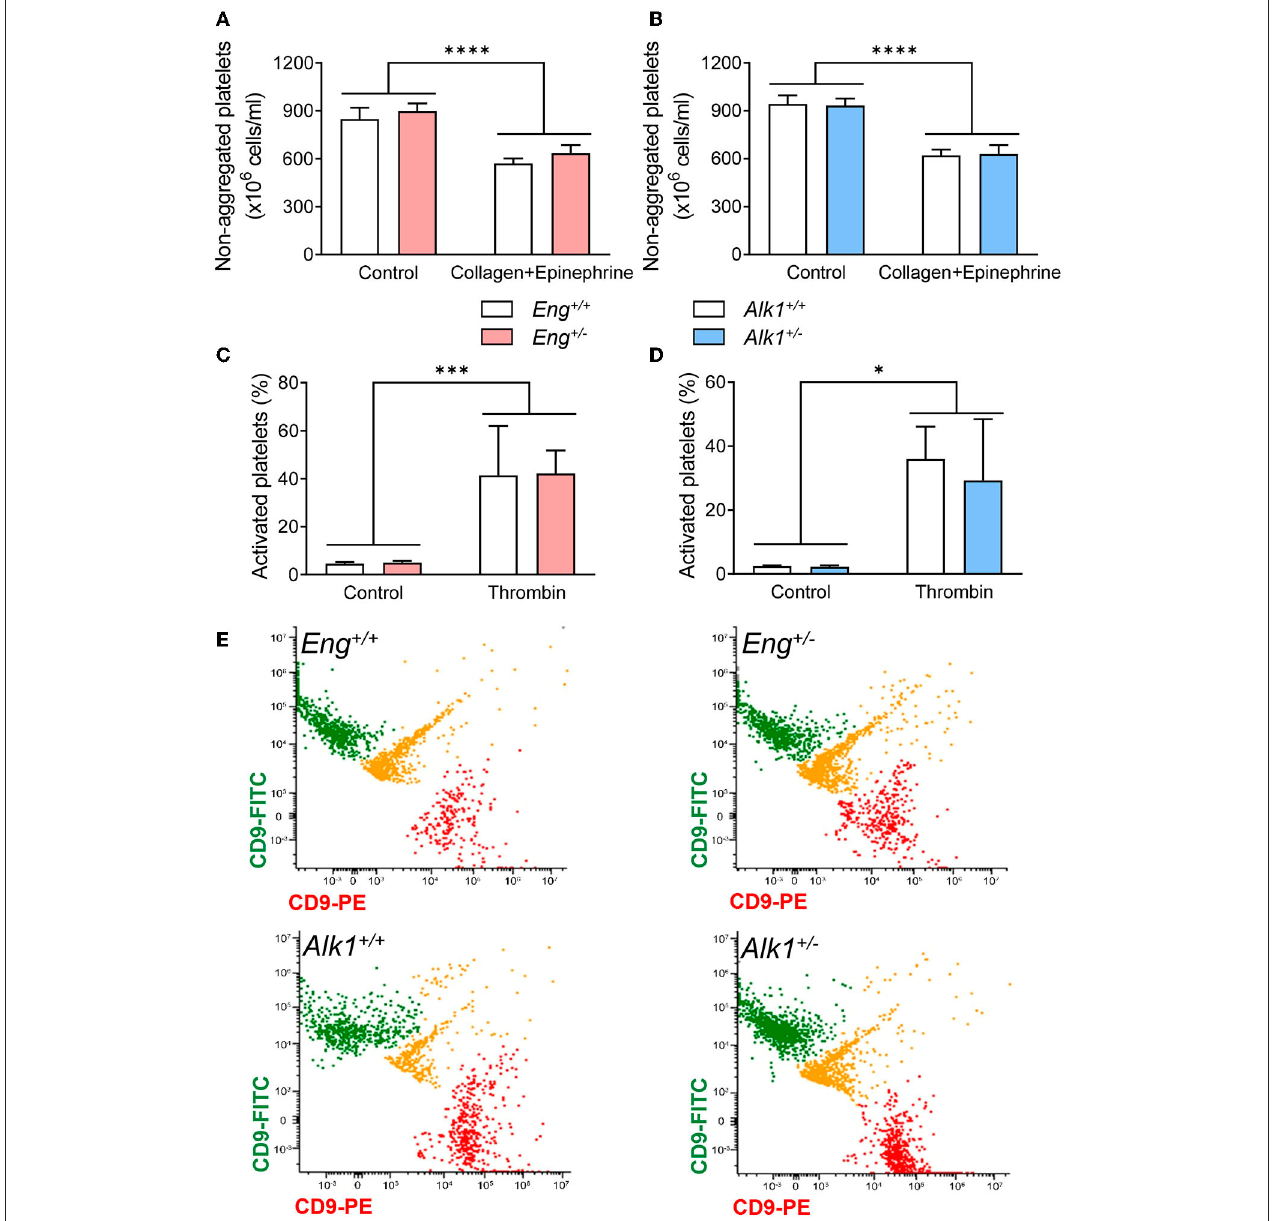
FIGURE 3 | (A,B) Number of non-aggregated platelets per mL before and after the induction of a thrombogenic event with a bolus of collagen and epinephrine in the HHT-1 murine model (A) , Eng + / − mice ( n = 8) and their respective controls Eng + / + ( n = 9); and in the HHT-2 murine model (B) , Alk1 + / − mice ( n = 10) and their respective controls Alk1 + / + ( n = 14). (C,D) Percentage of activated platelets, determined by flow cytometry, after treatment with thrombin of diluted blood from Eng + / − mice ( n = 7 mice) and their respective controls Eng + / + ( n = 6 mice) (C) or from Alk1 + / − mice ( n = 6 mice) and their controls Alk1 + / + ( n = 5 mice) (D) . (E) Representative images, from 3 independent experiments, of flow cytometry analysis of platelet aggregation after thrombin stimulation of diluted blood from Eng + / + , Eng + / − , Alk1 + / + , and Alk1 + / − . Platelets are divided into 2 populations that are labeled with PE or with FITC bound in both cases to CD9. If the thrombin stimulus stimulates aggregation, green and red colocalization events are observed, labeled in yellow. Results were considered statistically significant if p < 0.05 (ns: non-significant; *: p < 0.05; **: p < 0.01; ***: p < 0.001; ****: p <